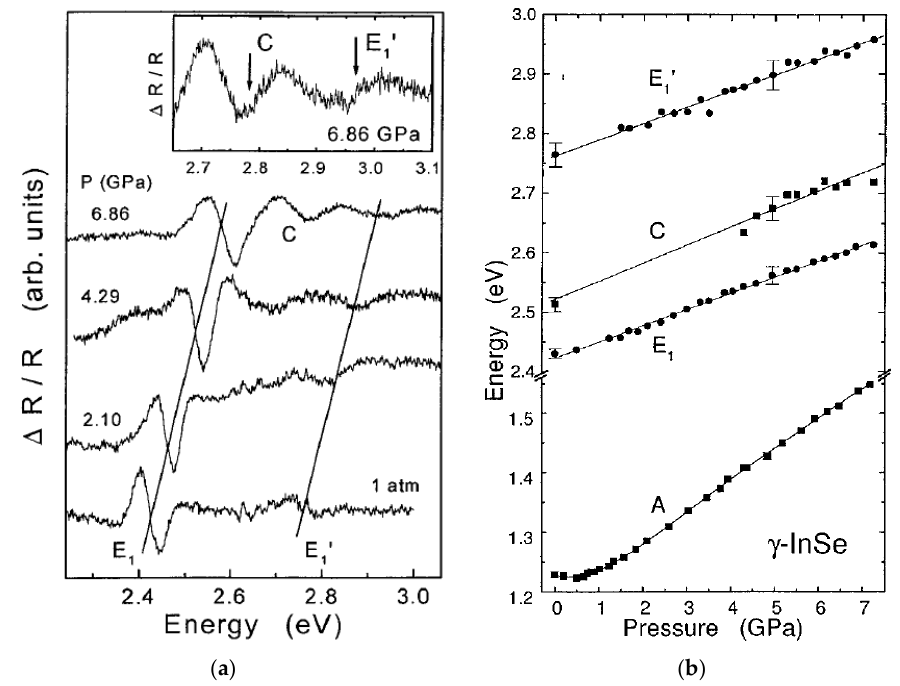
Figure 10. Optical properties of γ -InSe under pressure. ( a ) PMR spectra of γ -InSe at different pressures in the spectral range of direct allowed transitions. ( b ) Pressure dependence of the direct transitions in InSe [62].